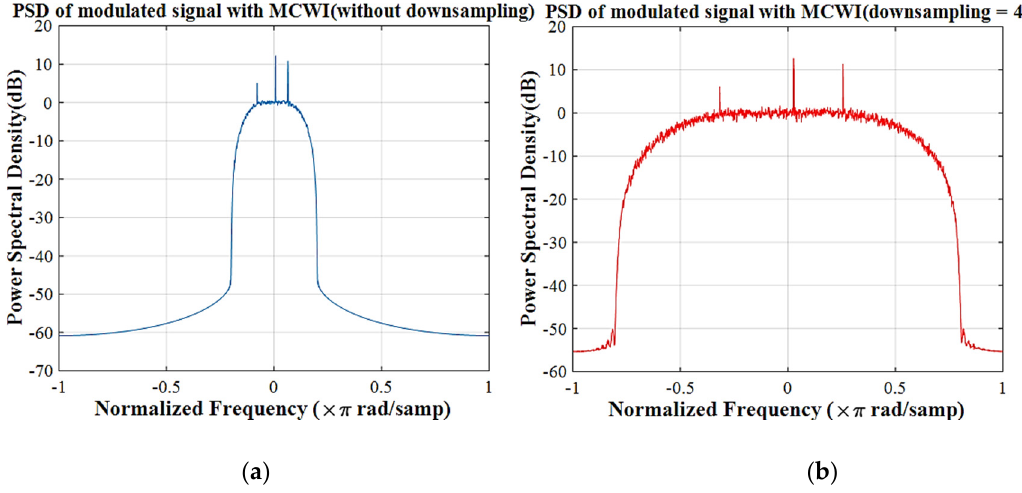
Figure 3. ( a ) Original power spectrum of a modulated signal ( b ) power spectrum of the signal after downsampling.